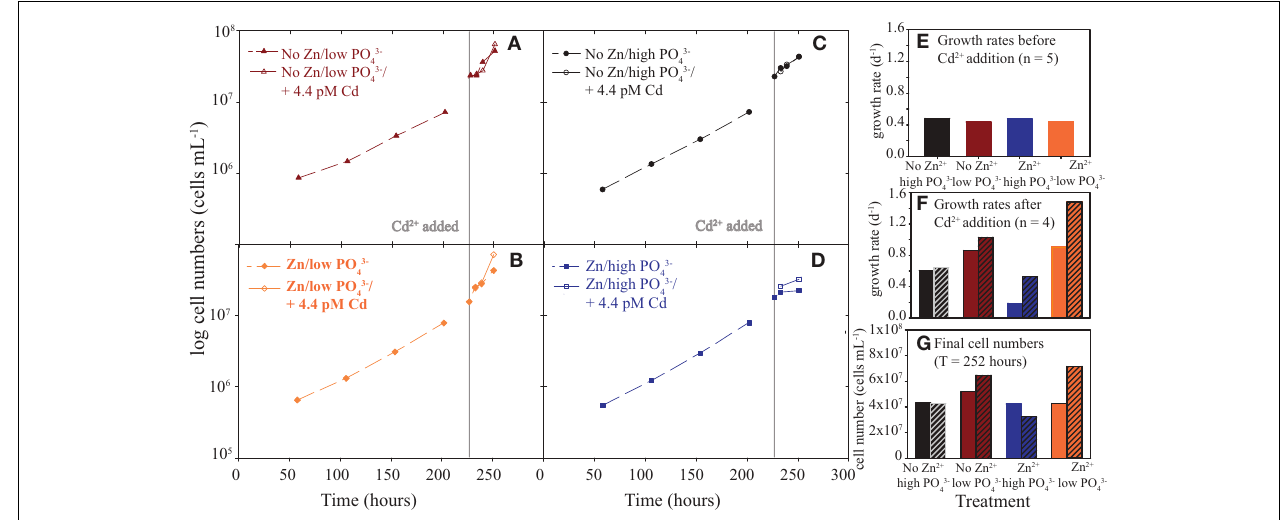
FIGURE 3 | Cell numbers vs. time, growth rates, and final cell numbers. (A) no Zn/low PO 43 − with and without short-term Cd addition, (B) Zn/low PO 43 − with and without short-term Cd addition, (C) no Zn/high PO 43 − with and without short-term Cd addition, (D) Zn/high PO 43 − with and without